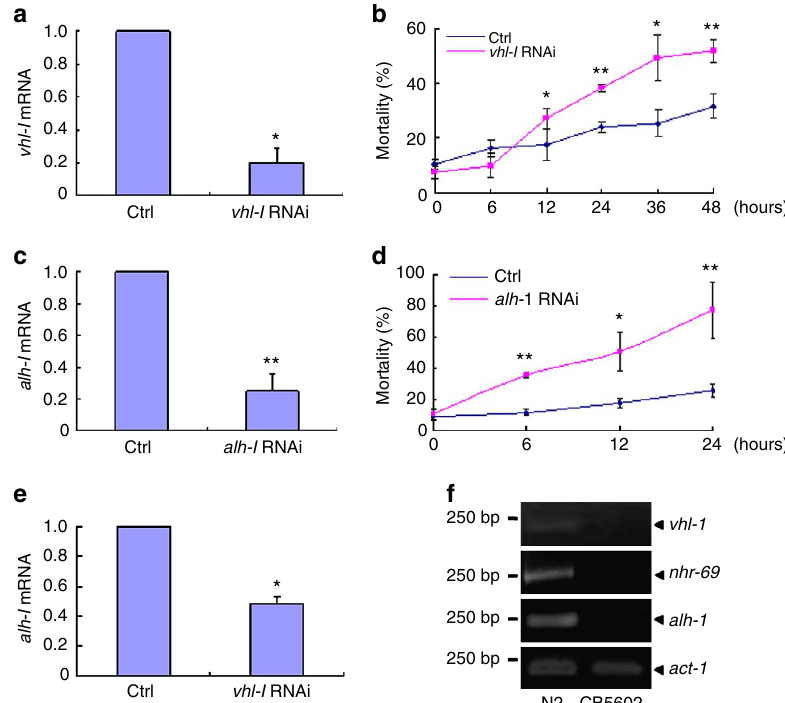
Figure 10 | Regulation of anthracycline toxicity and ALDH2 expression by VHL are conserved. ( a )The mRNA of vhl-1 in vhl-1 RNAi C.elegans . ( b ) The mortality of indicated vhl-1 RNAi C.elegans treated by 20 m gml (cid:2) 1 doxorubicin for different time. ( c ) The mRNA of alh-1 in alh-1 RNAi C.elegans . ( d ) The mortality of indicated alh-1 RNAi C.elegans treated by 20 m gml (cid:2) 1 doxorubicin for different time. ( e ) The mRNA of alh-1 detected by semi-quantitative RT–PCR in vhl-1 RNAi C.elegans . ( f ) The mRNA expression of indicated genes detected by semi-quantitative RT–PCR in vhl-1 deficiency C.elegans CB5602. Ctrl represents control. RNAi represents RNA interference. Twenty-five cycles used for semi-quantitative RT–PCR. Columns, means of three independent experiments; bars, s.d. (* P o 0.05, ** P o 0.01 for t -test). Tissue samples and immunohistochemistry . Paraffin-embedded tumour tissues air in a humidified atmosphere at 37 (cid:2) C. Hypoxic treatment was performed in a specially designed hypoxia incubator (Thermo Electron, Forma, MA, USA) with and normal adjacent tissues from Ruijin Hospital. The immunohistochemical 1% O 2 , 5% CO 2 and 93% N 2 . analysis was performed on the 4 m m thick fraction mounted on charged slides and NATURE COMMUNICATIONS|8:15337|DOI: